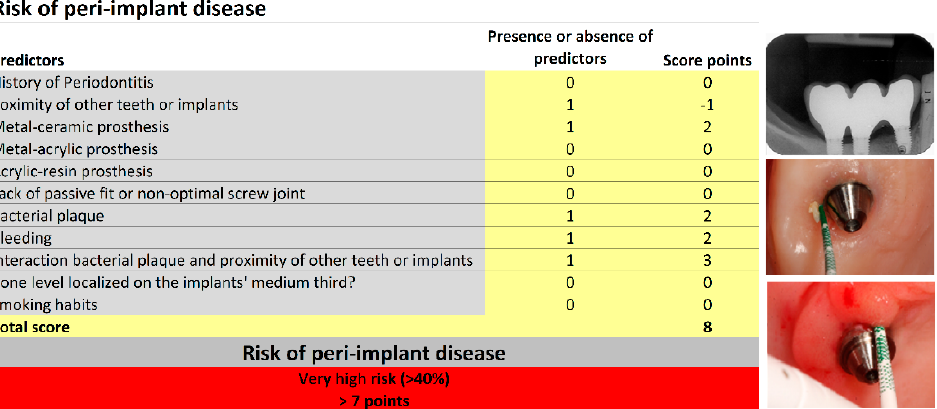
Figure 2. Baseline periapical radiograph (at one year of follow-up) from a 59 year old female patient with no history of periodontitis who was a non-smoker, rehabilitated with a three-unit implant-supported rehabilitation [three implants of 7 mm in length, positions #44–#46; Risk points = − 1 due to adjacent implants or teeth present) restored using metal–ceramic material (Risk points = 2). Bacterial plaque (Risk points = 2) and bleeding (Risk point = 2) were present, and the bone level was located on the implants’ coronal third. Due to the presence of bacterial plaque and the presence of adjacent implants or teeth, 3 risk points were added. A total score of 8 points was registered for this patient which corresponded to the very high-risk group.